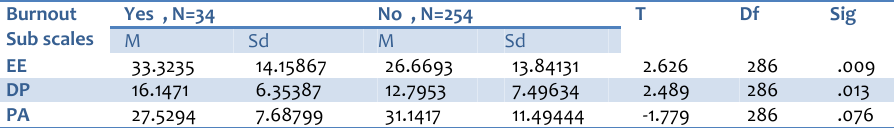
Table 8: T-test on mean difference of burnout based on conflict with colleagues Yes , N=34 No , N=254 Burnout Sub scales